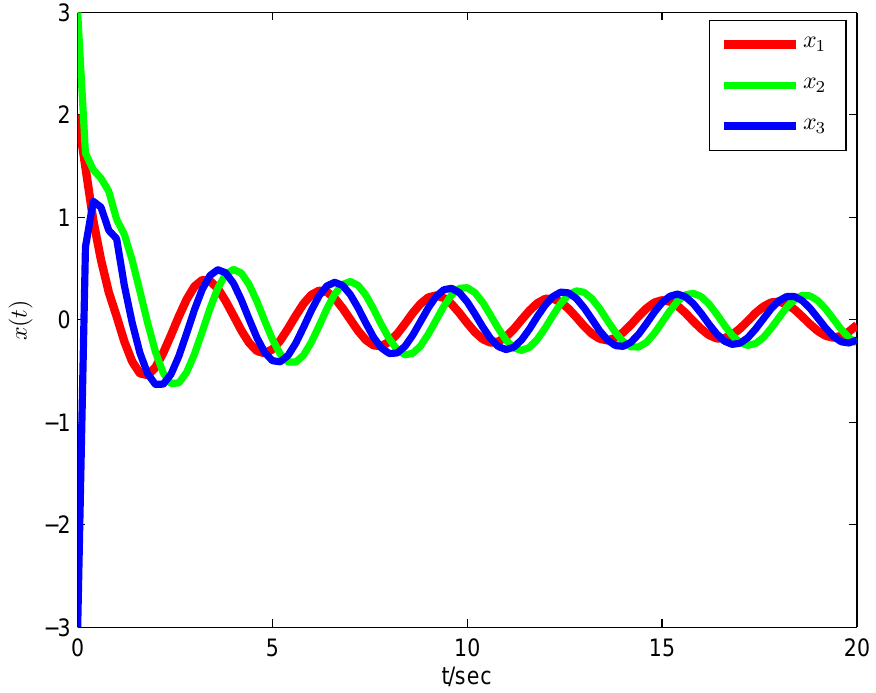
Figure 1. The state trajectories of the fractional-order neural network model (50) in Example